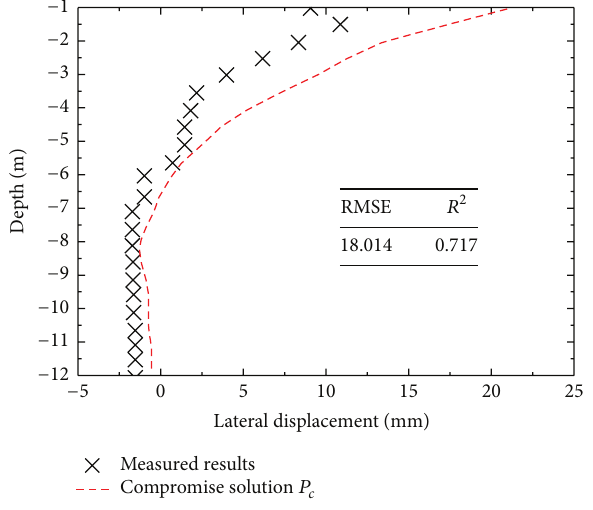
Figure16:Comparisonoffieldobservedandcalculatedcraterdepth with blow count using compromise solution from 1st blow and 2nd blow at impact location A.